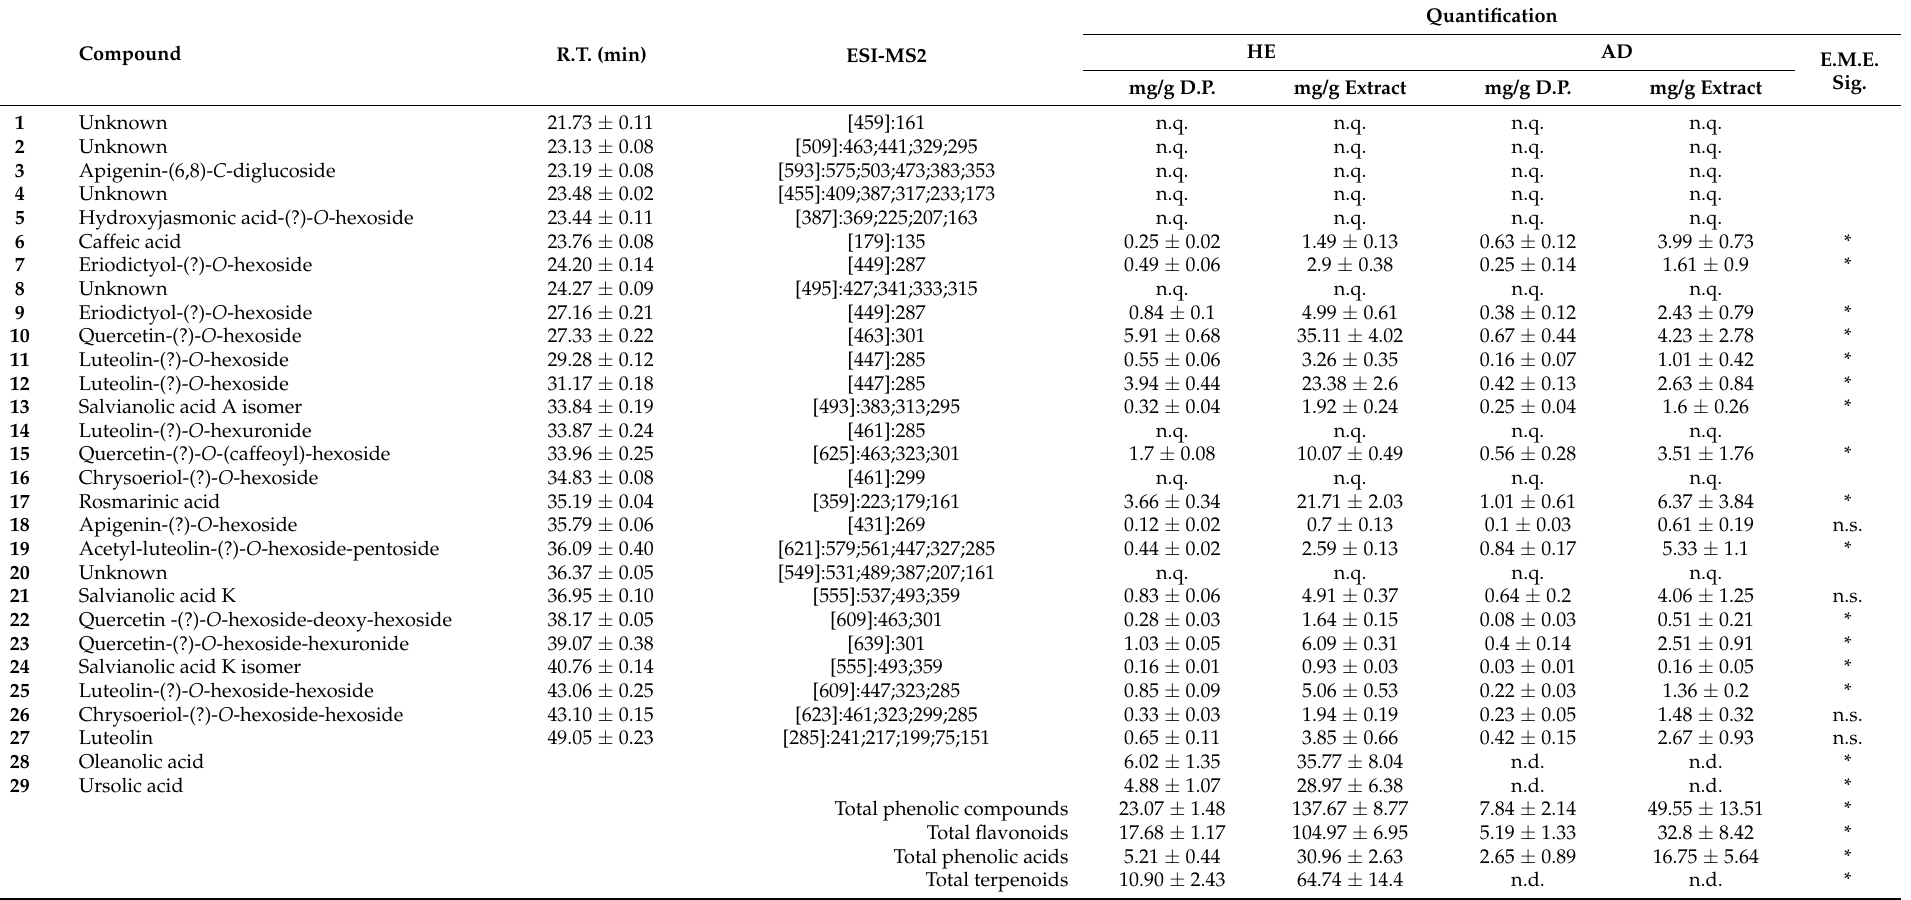
Table 2. Phytochemical composition of T. capitellatus hydroethanolic (HE) and aqueous decoction (AD) extracts obtained by HPLC/DAD-ESI/MS n analysis.